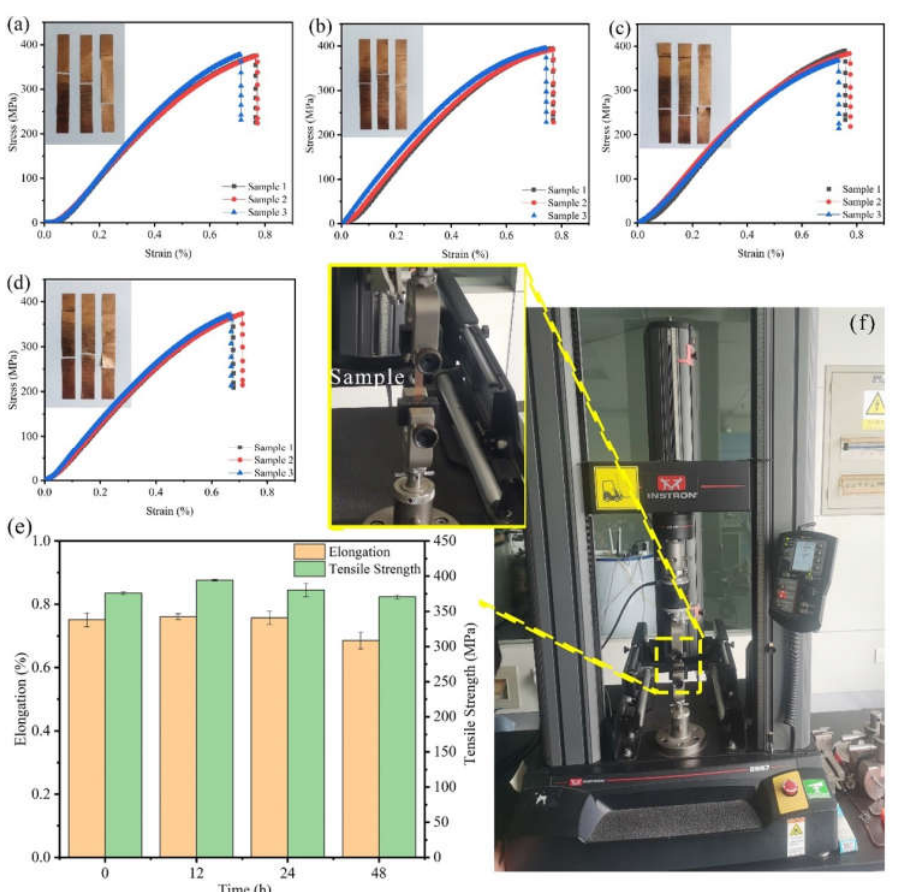
Figure 1. Stress–strain curves and images of Cu foils treated by DCT for ( a ) 0 h ( b ) 12 h, ( c ) 24 h, and ( d ) 48 h, ( e ) effects of DCT time on the uniaxial tensile performance, ( f ) a picture of the universal machine.